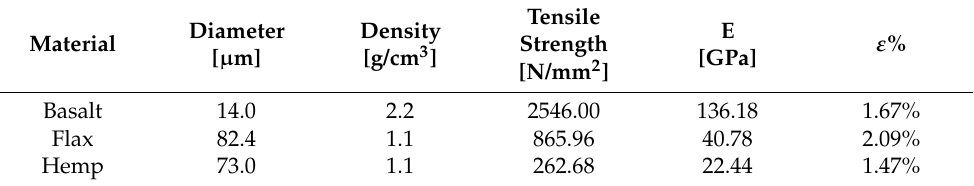
Table 3. Mechanical and physical properties of natural fibres [26].